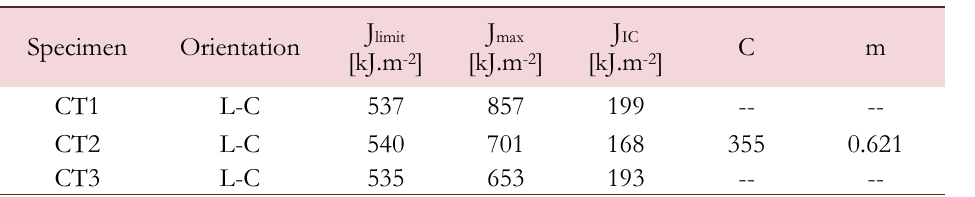
Table 3: Results of J-Integral tests for the weld AISI 316L